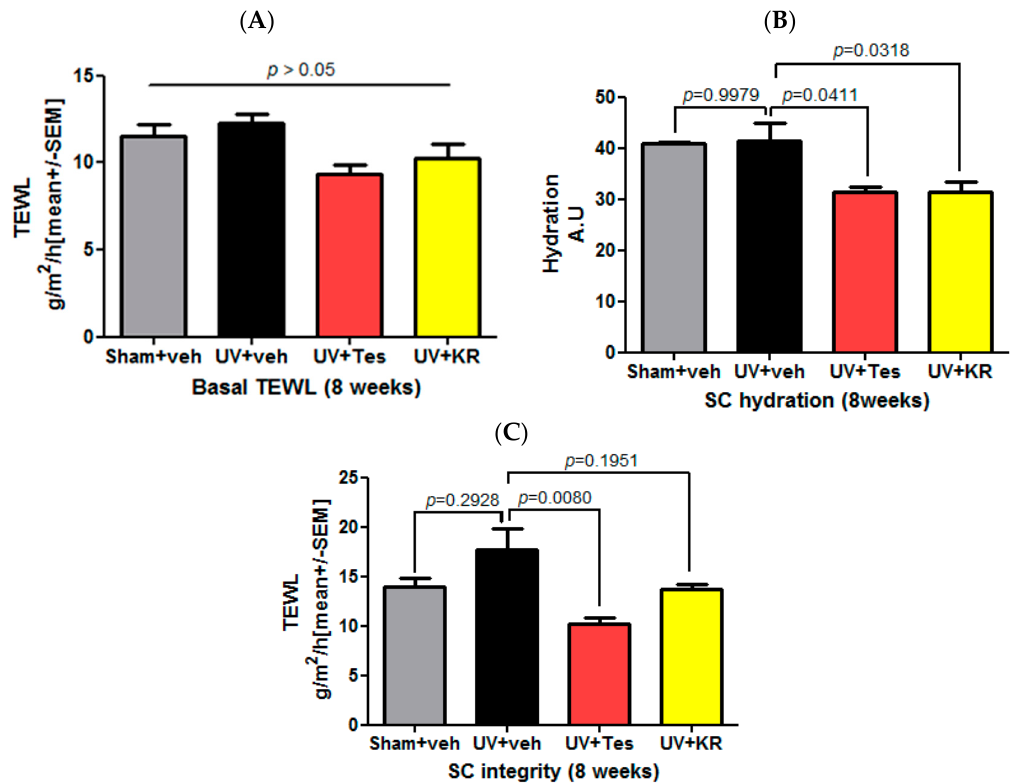
Figure 7. Effect of a mixture of extracts of Kochia scoparia and Rosa multiflora (KR) on the epidermal permeability barrier in photoaging skin. Basal transepidermal water loss (TEWL), stratum corneum (SC) hydration, and SC integrity were measured after UV radiation and topical application of KR, vehicle (veh), or tesaglitazar (Tes) for 8 weeks. An 8-week course of UV radiation on 18-week-old mice did not significantly affect basal TEWL, SC hydration, and SC integrity. In photoaging skin, neither KR nor Tes affected basal TEWL ( A ), but both decreased SC hydration significantly ( B ). To evaluate SC integrity, we measured TEWL after four sequential strippings with D-squame ® . KR slightly increased SC integrity in photoaging skin, while Tes increased it significantly ( C ).